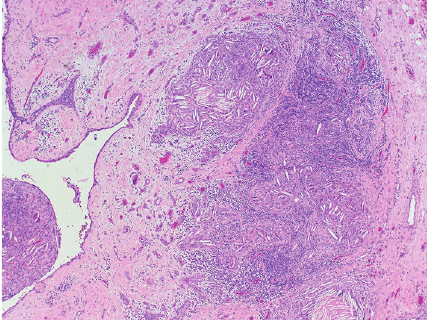
Figure 3: Hematoxylin and eosin, 4x. Cholesterol granuloma (right) with adjacent epithelial lined cyst